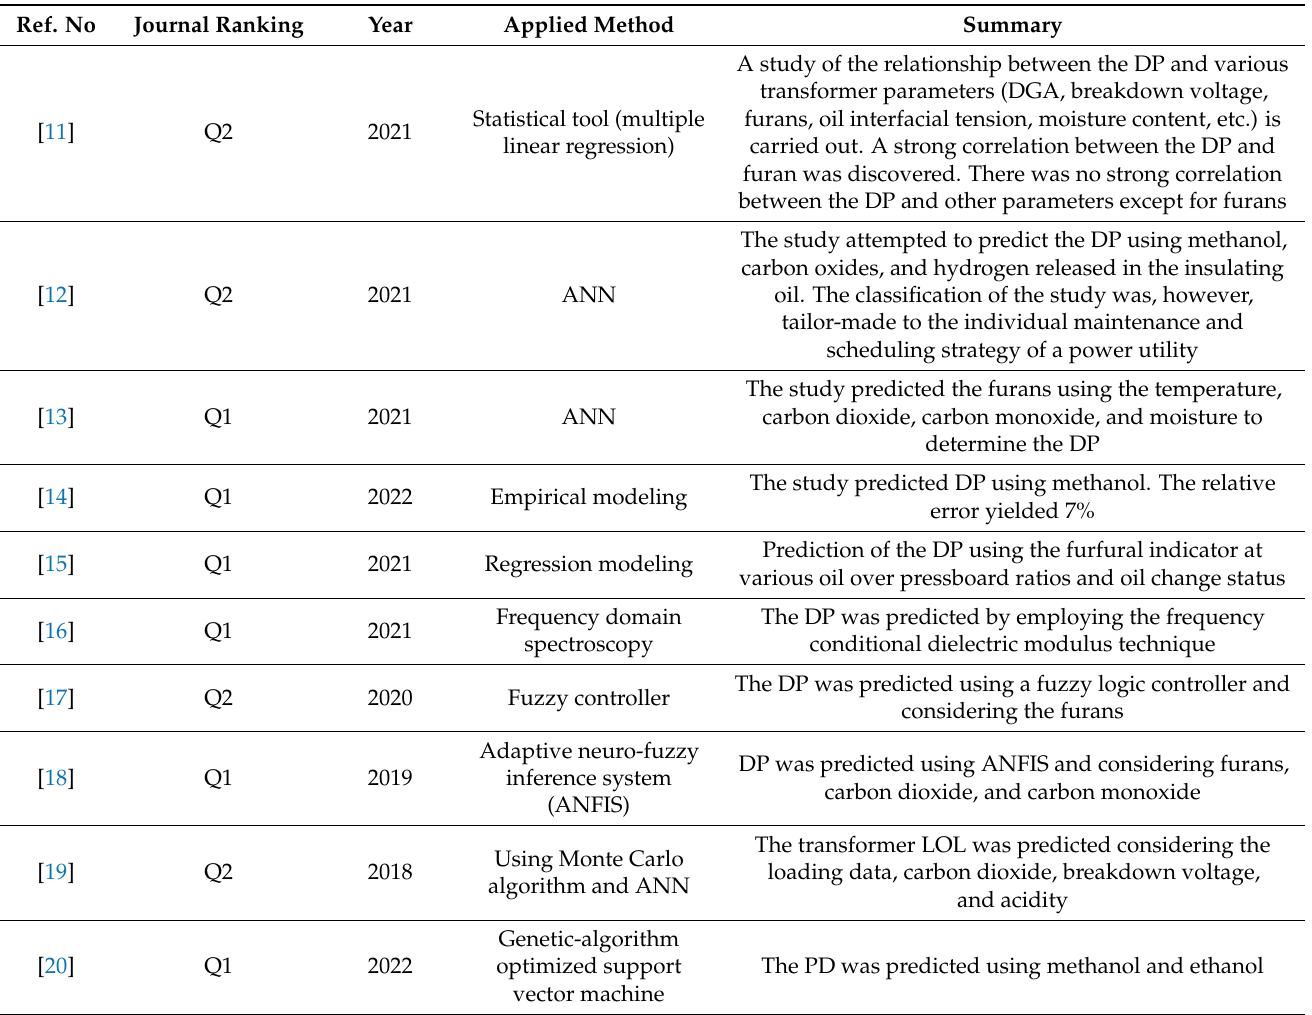
Table 1. A summary of recent research